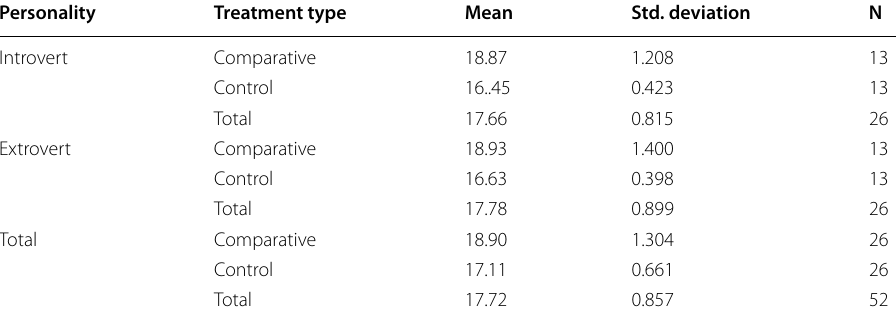
Table 4 The results of descriptive statistics for scores of post-tests Personality